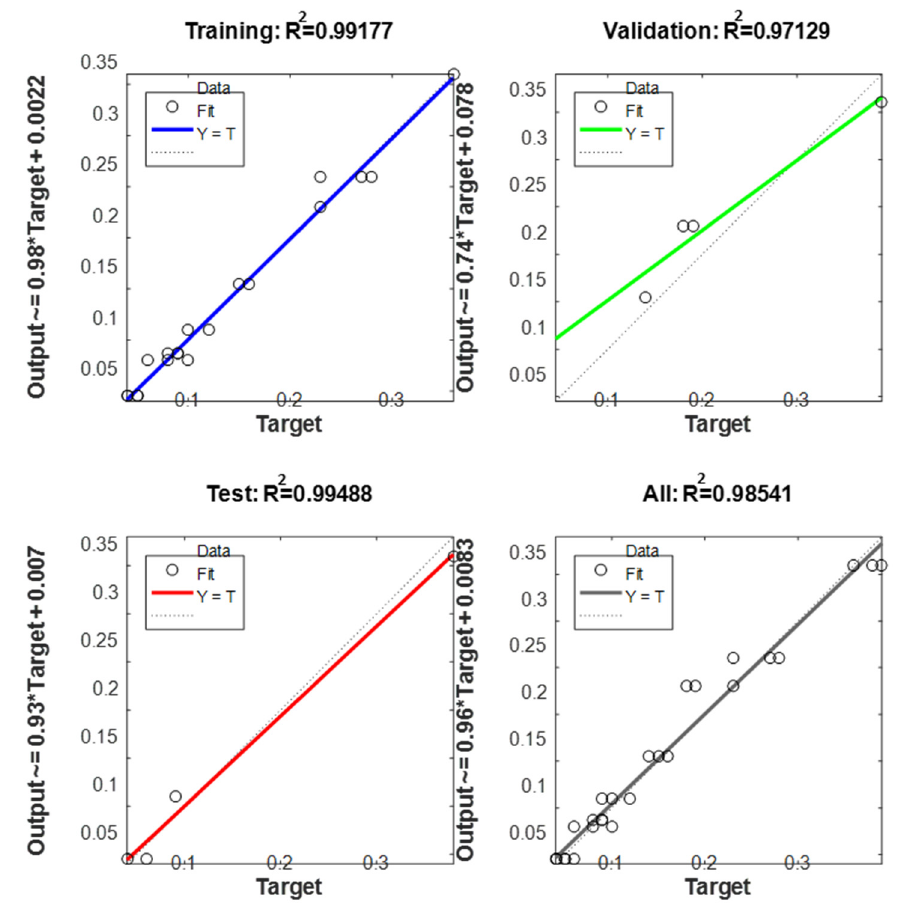
Figure 5. The ANN regression plot.